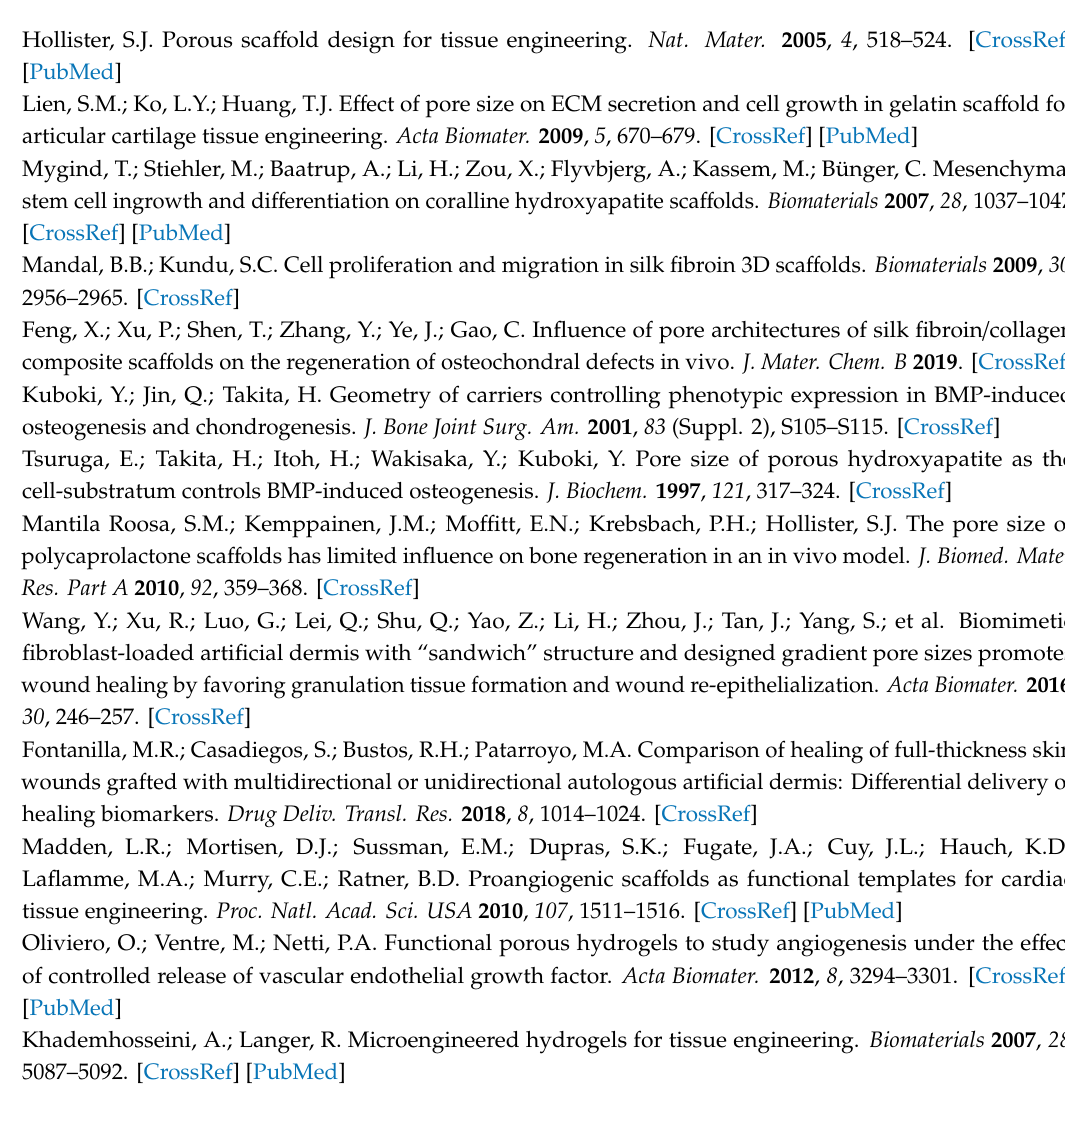
Figure S1: Freezing profiles of 0.75% GG hydrogels, Figure S2: E ff ect of freezing conditions (standard method, NFD, and IFD at − 20, − 80, and − 210 ◦ C) over the properties of 0.75% GG dried polymeric structures and spongy-like hydrogels., Figure S3: Water uptake of 1.25% GG spongy-like hydrogels at − 20, − 80, and − 210 ◦ C using di ff erent freezing systems, Figure S4: Sca ff olds reproducibility, Figure S5: E ff ect of freezing conditions (standard method, NFD, and IFD at − 20, − 80, and − 210 ◦ C) over hDFb behavior in 0.75% GG spongy-like